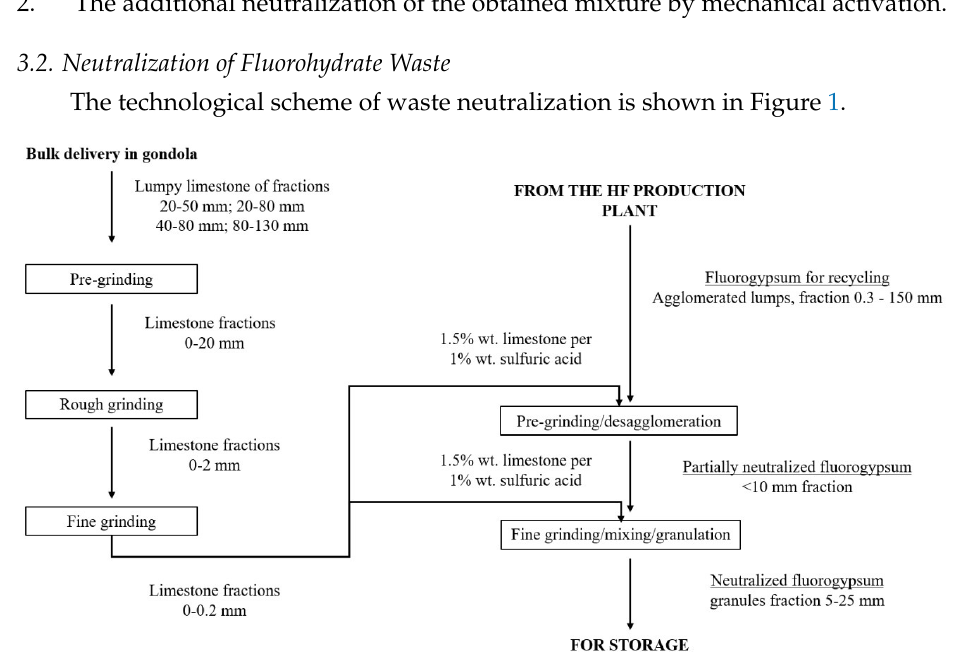
Table 1. The standard chemical composition of limestone. Description of Parameter Range